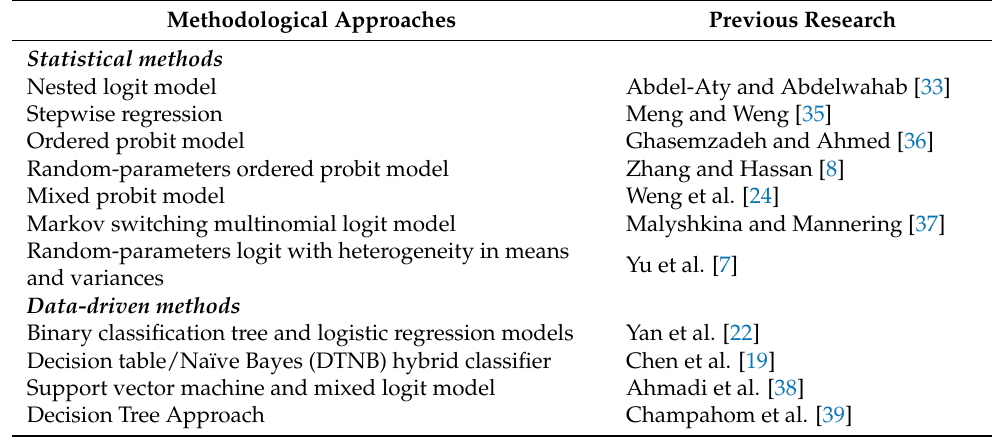
Table 2. A summary of methodological approaches used for analysis on rear-end crashes.